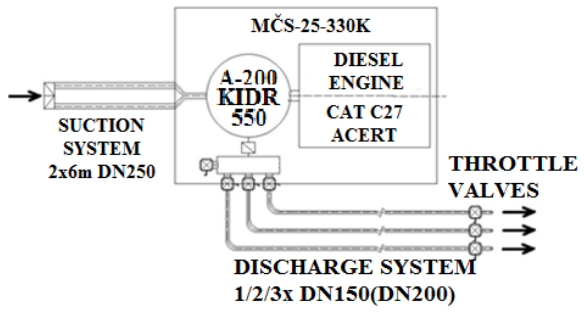
Fig. 1. Scheme of HCPM with suction and discharge system